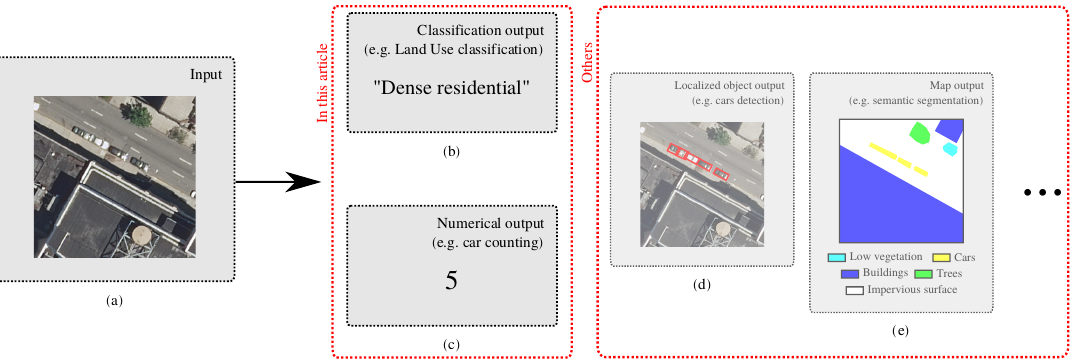
Figure 2. Examples of type of information which can be extracted from remote sensing images. (a) input image, (b) class of an image (in this case, the land use, (c) counts (in this case, cars), (d) localized objects (in this case, cars) and (e)